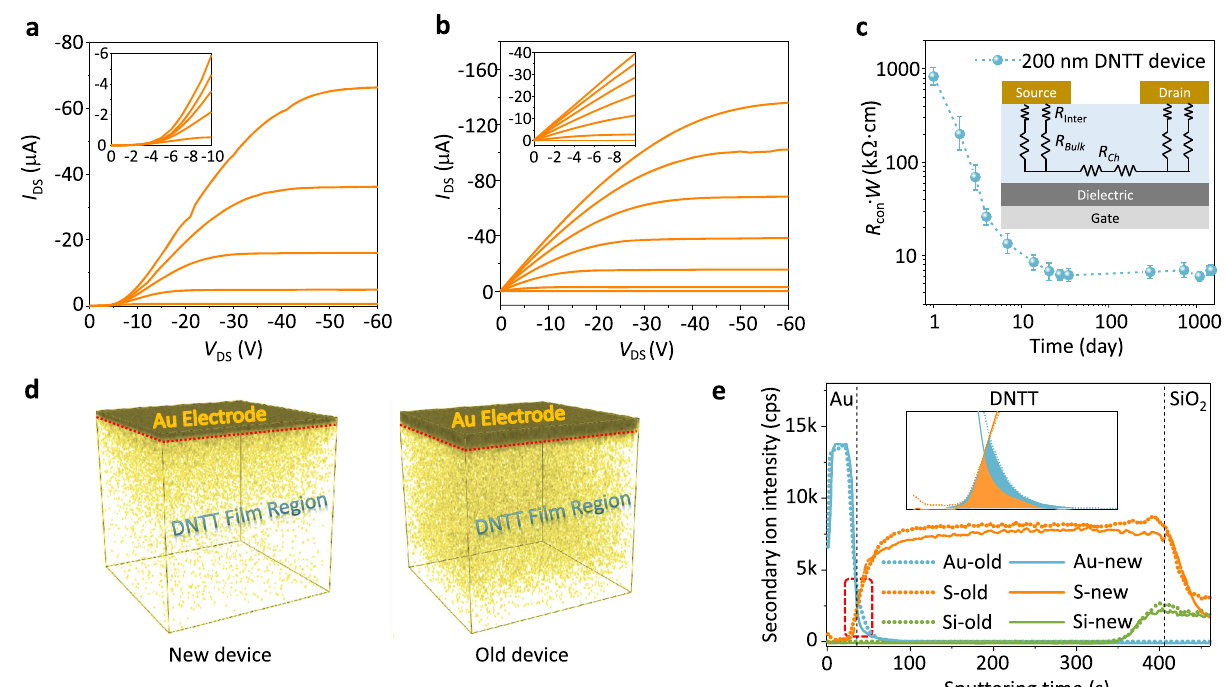
Fig. 4 Self-optimized contact resistance. Output curves of the 200 nm DNTT OFET a before and b after one month of storage. The insets are output curves in the linear regime. The channel length and width of the tested OFETs are 100 and 1000 μ m, respectively. c The plot of contact resistance ( R con ) versus storage time. “ W ” in the axis denotes the channel width. The inset is a schematic diagram of the charge transport circuit in OFET. R Inter , R Bulk , and R Ch are the electrode/semiconductor interface resistance, bulk resistance, and channel resistance, respectively. All error bars indicate standard errors based on multiple measurements. d The three-dimensional gold element distribution map (TOF-SIMS measurements) of (left panel) the new device and (right panel) the old device in the DNTT fi lm region. e The depth pro fi les of the new device (solid line) and the old device (dashed line). The inset represents the enlarged overlap region of the gold element and DNTT, which is marked with a red rectangle in ( e ). The orange and blue regions indicate the overlap of the gold element and DNTT in the old device and new device,